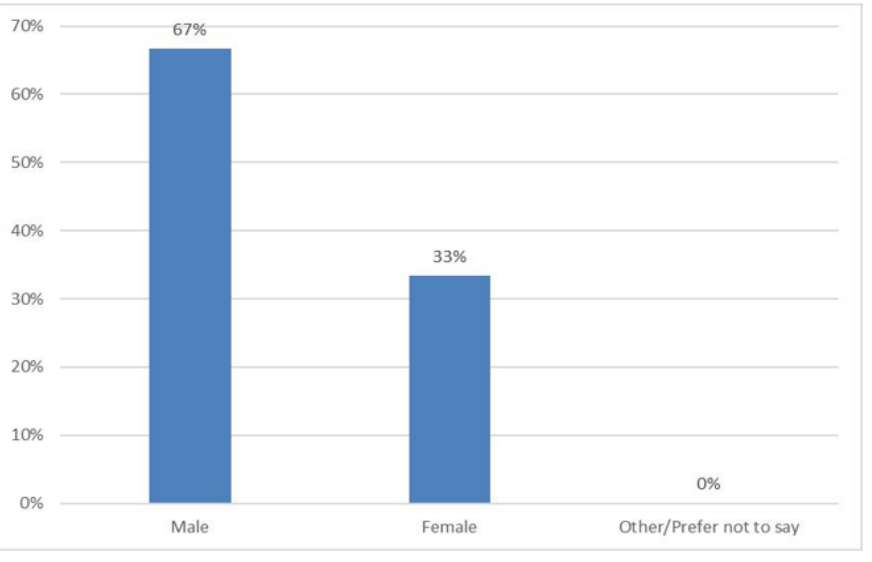
Figure 7. What is Your Gender?